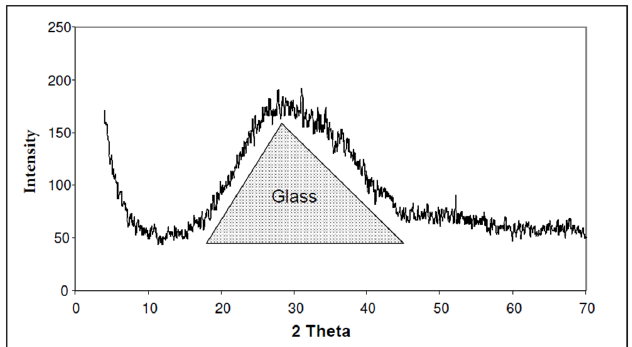
Figure 5. X-ray di ff ractogram of the glass powder of d 50 = 33 µ m. The dotted line shows the bulge of the baseline indicating the presence of amorphous